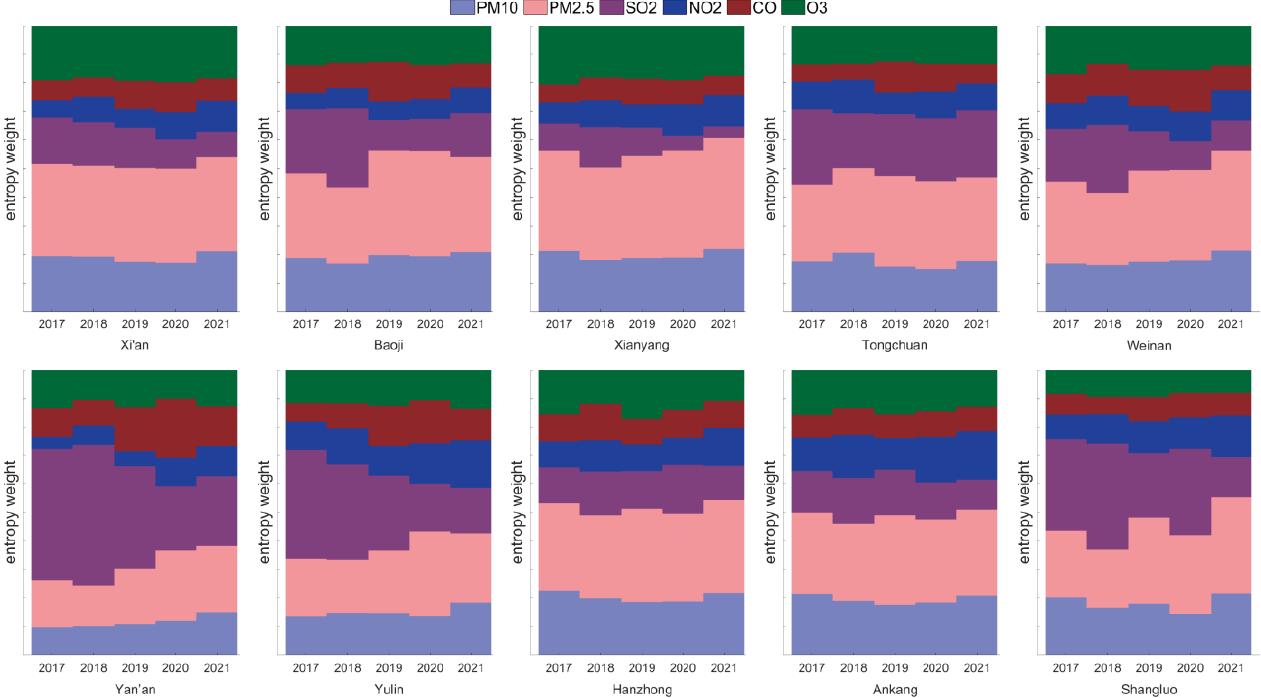
Figure 3. The annual entropy weights of 6 pollutants in 10 cities from 2017 to 2021.